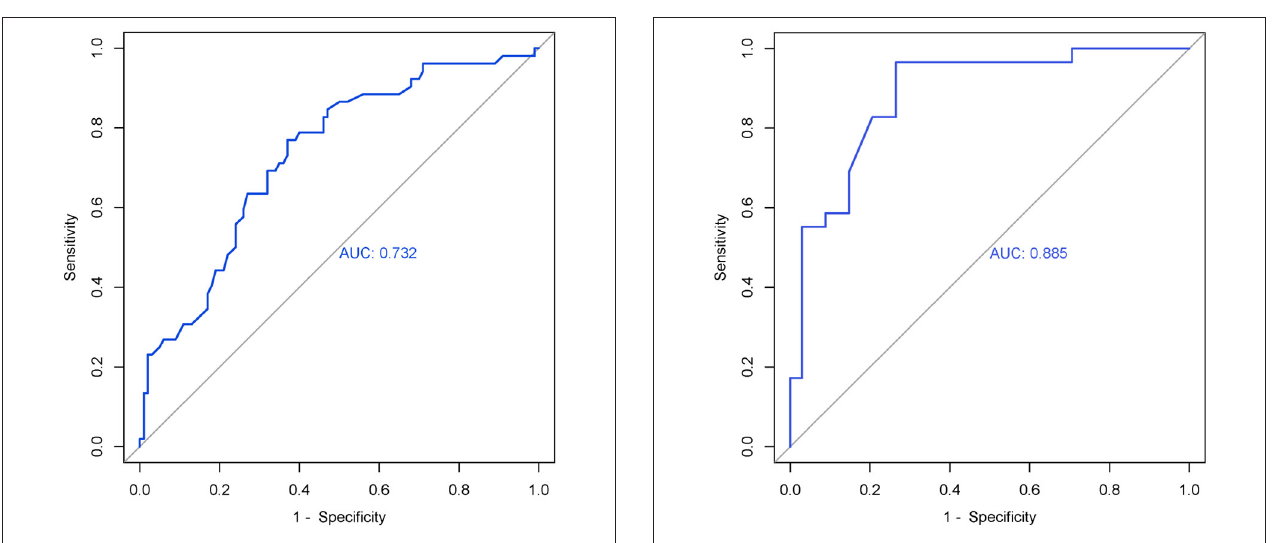
FIGURE 2 | ROC curve of the right SMA’s cortical thickness (0 weeks) in MDD. AUC = 0.732 (95% CI = 0.233–0.399), sensitivity = 76.9%, specificity = 63%, cutoff value = 0.399.